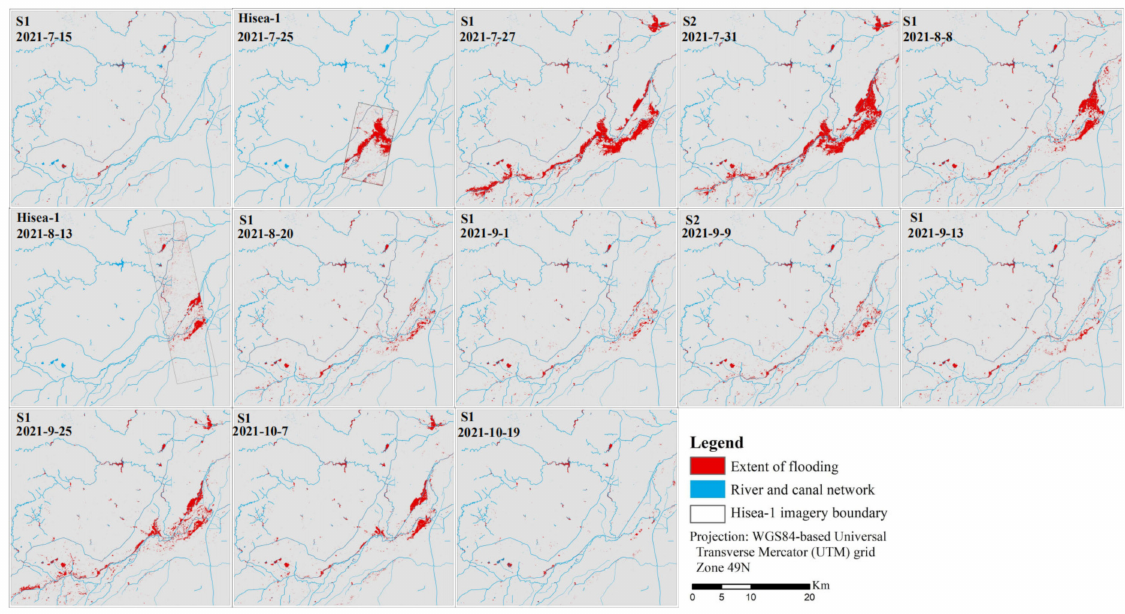
Figure 4. Flood spatial distribution maps caused by the 20 July 2021 extraordinary rainfall event in Henan, China. The figure was plotted by Arcmap10.2 software. (S1: Sentinel-1 SAR data; S2: Sentinel-2 optical